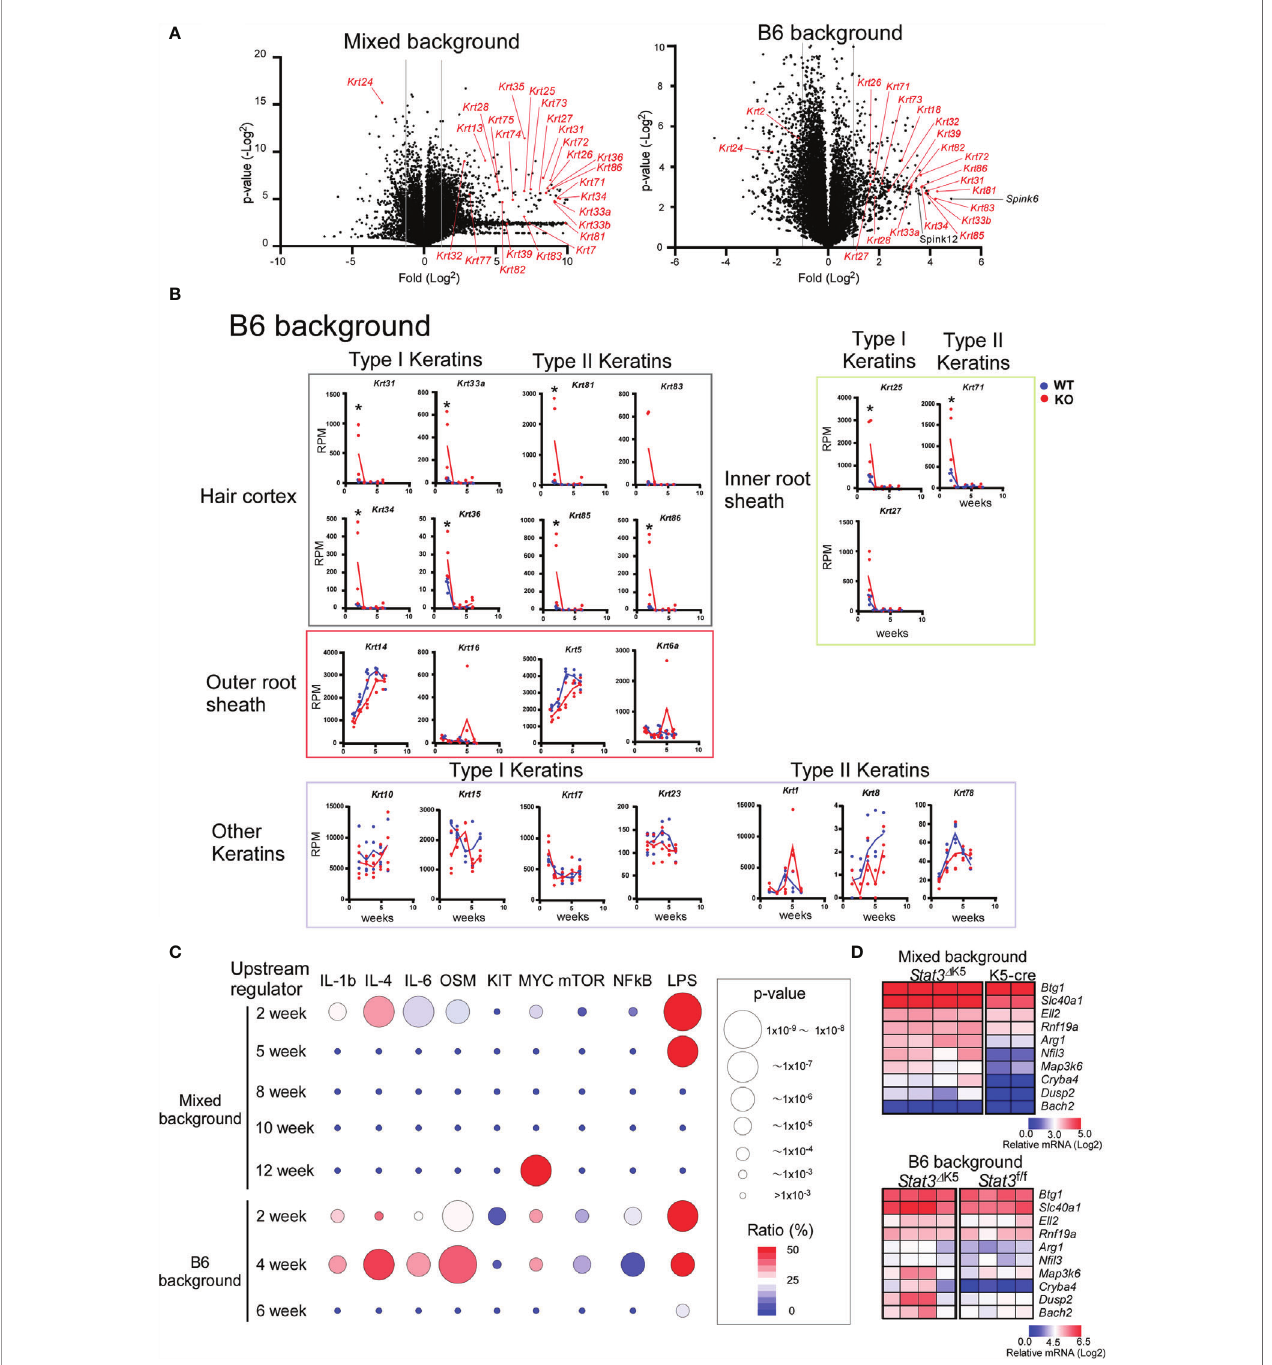
FIGURE 3 | Transition of gene expression of hair follicle (HF)-speci fi c keratins in ear skin from Stat3 D K5 mice. (A) Volcano plots showing changes in gene expression due to Stat3 de fi ciency in skin of 2-weeks-old mixed (left) or B6 background (right) mice. Keratin genes are indicated with red. (B) The expression pro fi les of HF- and non-HF keratins in the ear skin of B6 background Stat3 f/f (WT, n=4) or Stat3 D K5 (KO, n=4) mice bred under speci fi c pathogen-free (SPF) conditions. The blue and red lines indicate means for WT and KO, respectively. (C) The results of upstream analysis of differentially expressed genes (DEGs) of mixed or B6 mouse ear skin samples at indicated weeks of age using Ingenuity Pathway Analysis (IPA) are shown by p-values and gene coverage ratios for IL-1b, IL-4, IL-6, oncostatin M (OSM), c-Kit (KIT), c-Myc (MYC), mechanistic target of rapamycin kinase (mTOR), nuclear factor-kappa B (NFkB), and lipopolysaccharide (LPS) as upstream regulators. (D) Heatmaps show the expression patterns of genes shown to be under the control of LPS by the upstream analysis (C) in the skin of 2-week-old mixed background (top) and B6 background (bottom) Stat3 de fi cient (n=4) and suf fi cient (mixed background, n=4; B6 background, n=2) mice.